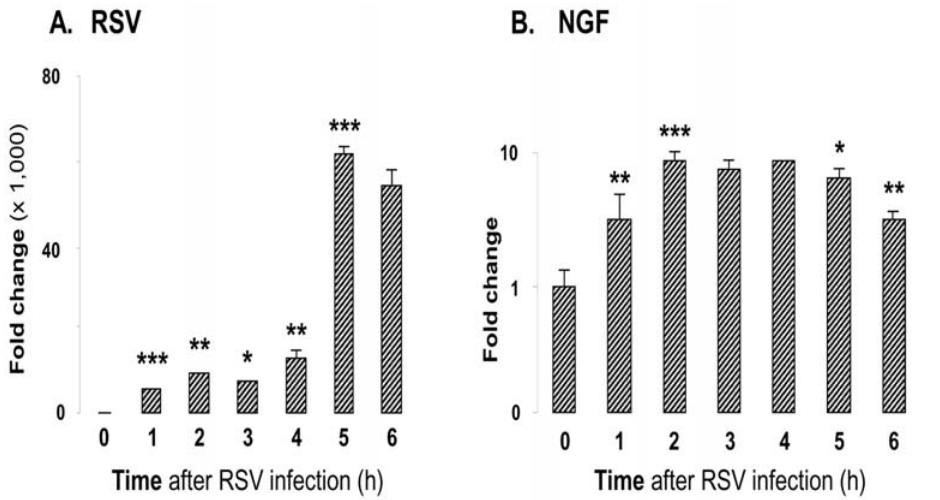
Figure 9. NGF transcripts induction in bronchial epithelial cells exposed to RSV. (A) RSV transcript levels. (B) NGF transcript levels. Bronchial epithelial cells were infected with 1 MOI of rgRSV. Cells were trypsinized at hourly intervals and cell pellets were collected for RNA extraction and real-time PCR analysis. Data shown are the average of 3 independent experiments performed in duplicate, and are presented as the mean 6 SEM (n=6). *= p , 0.05; **= p , 0.01; ***= p , 0.001 compared to previous time